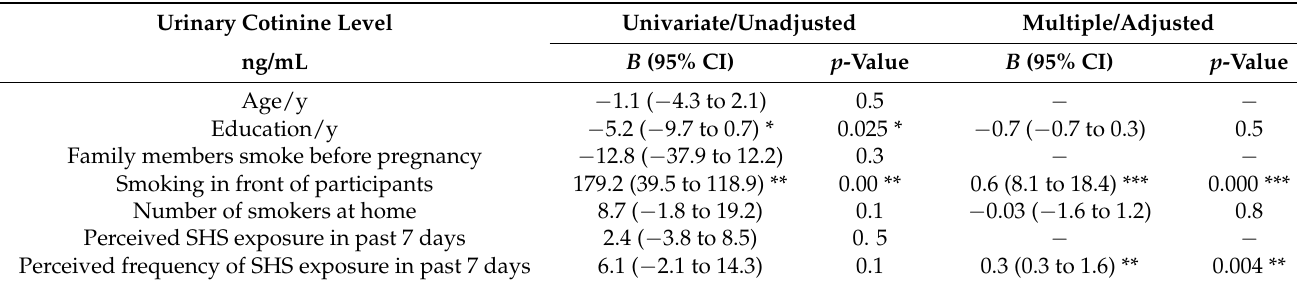
Table 3. Univariate and multiple regression analysis of the factors associated with urinary cotinine levels of pregnant